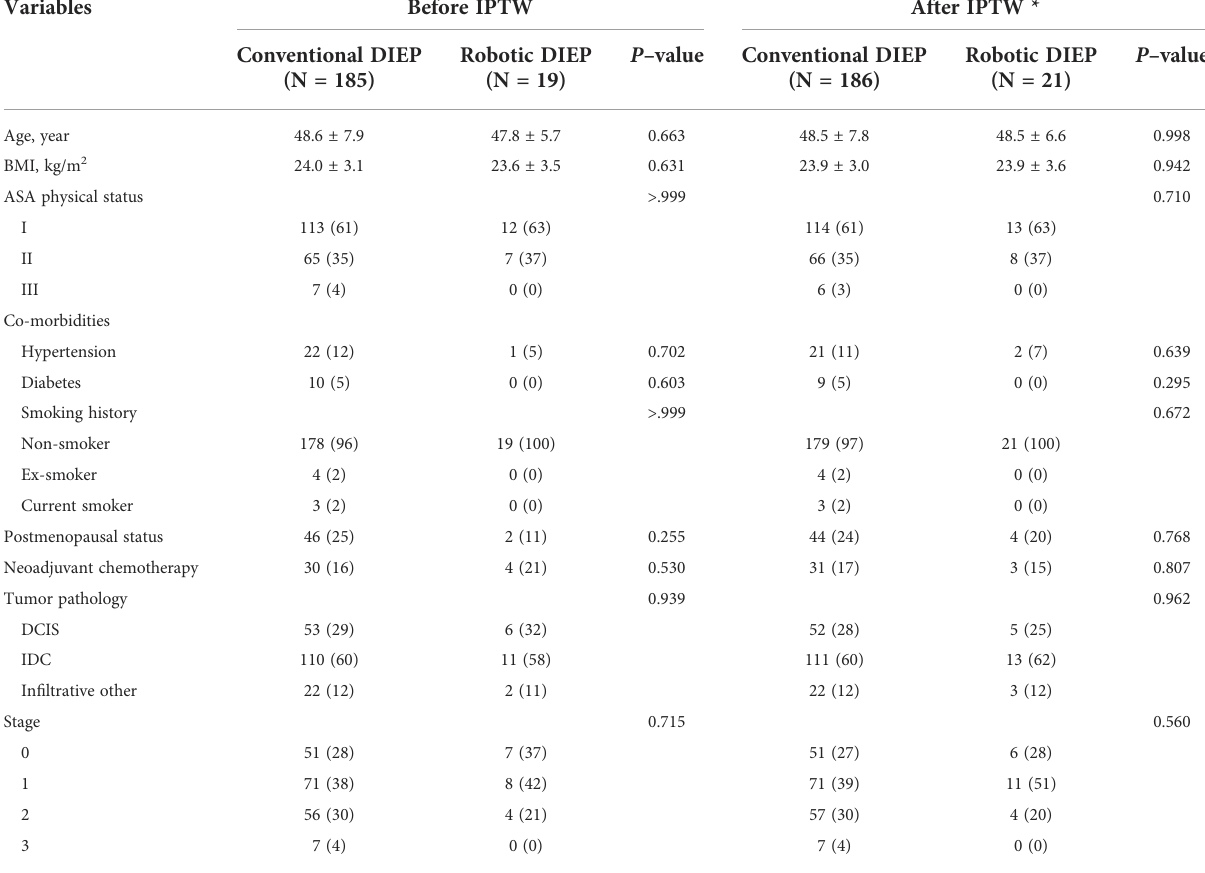
TABLE 1 Demographic characteristics by using Inverse Probability of Treatment